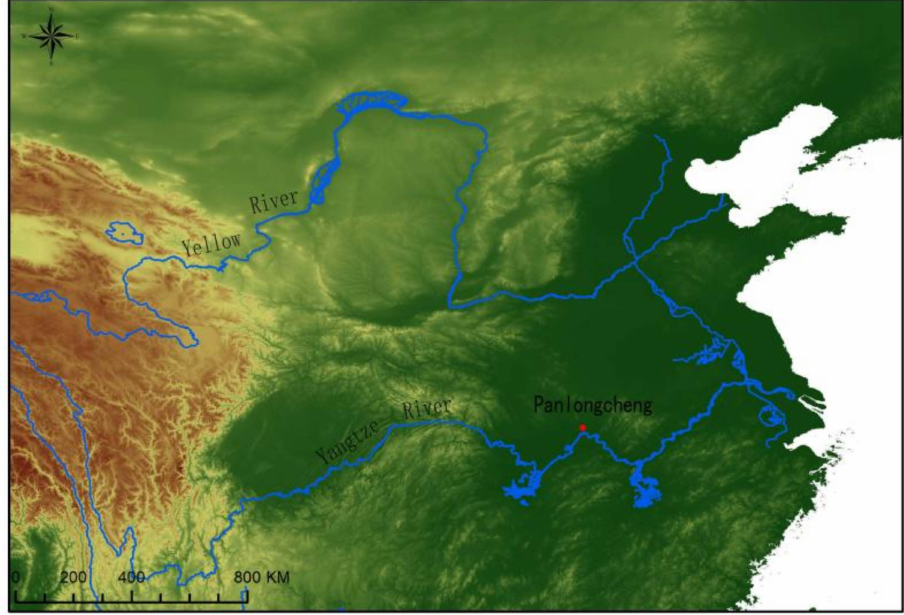
Figure 1. Map showing the location of the Panlongcheng